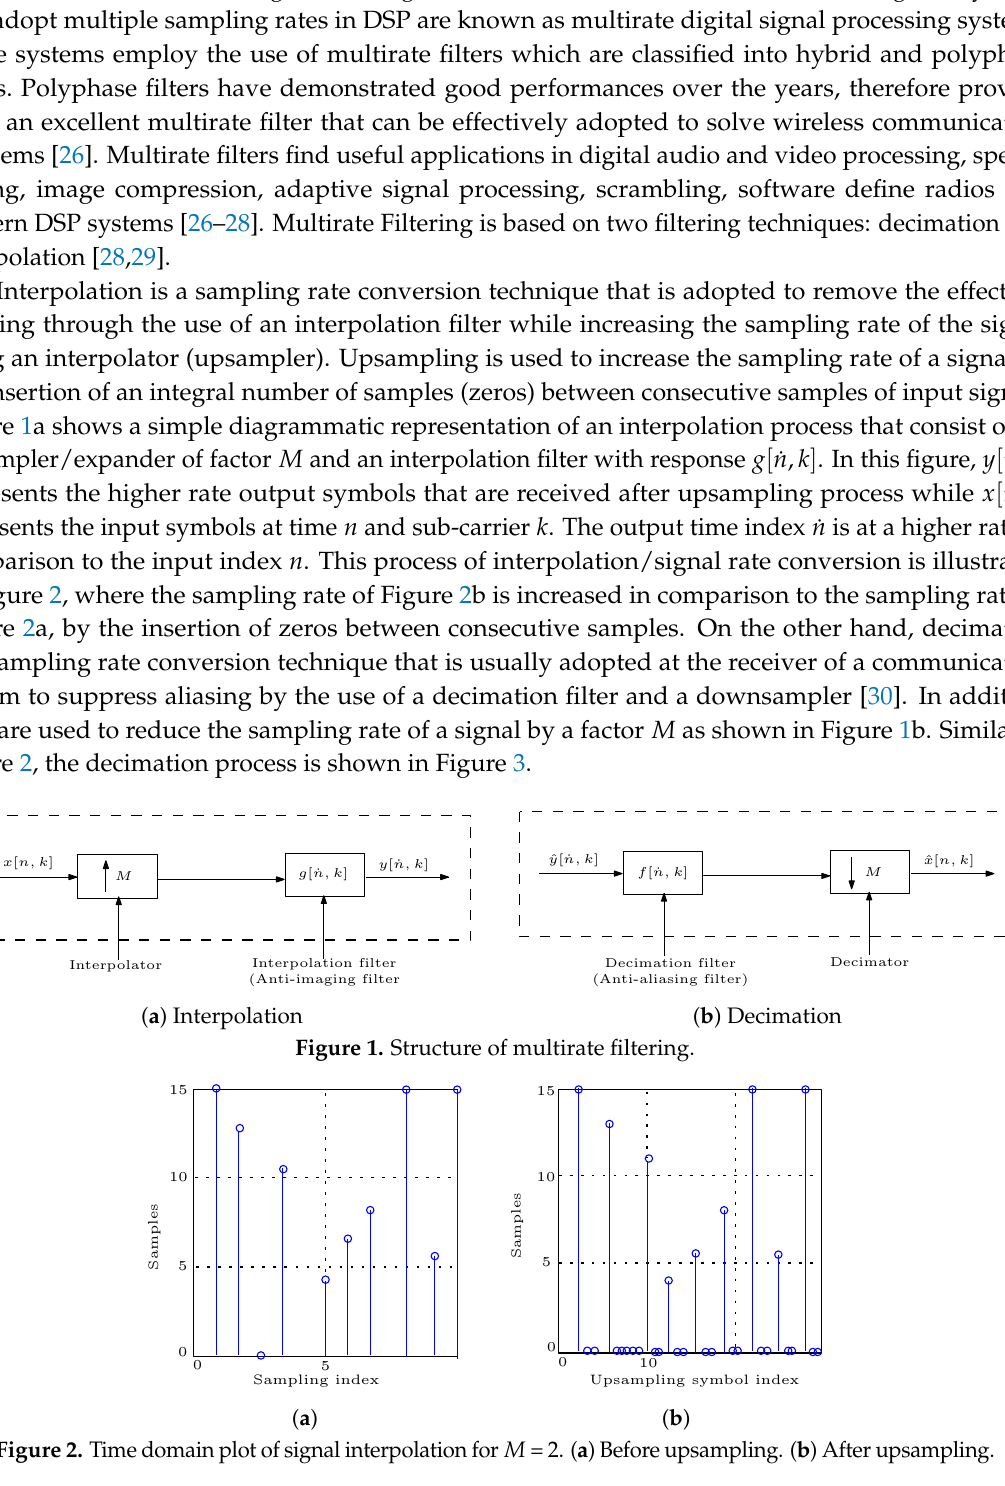
Figure 2. Time domain plot of signal interpolation for M = 2. ( a ) Before upsampling. ( b ) After